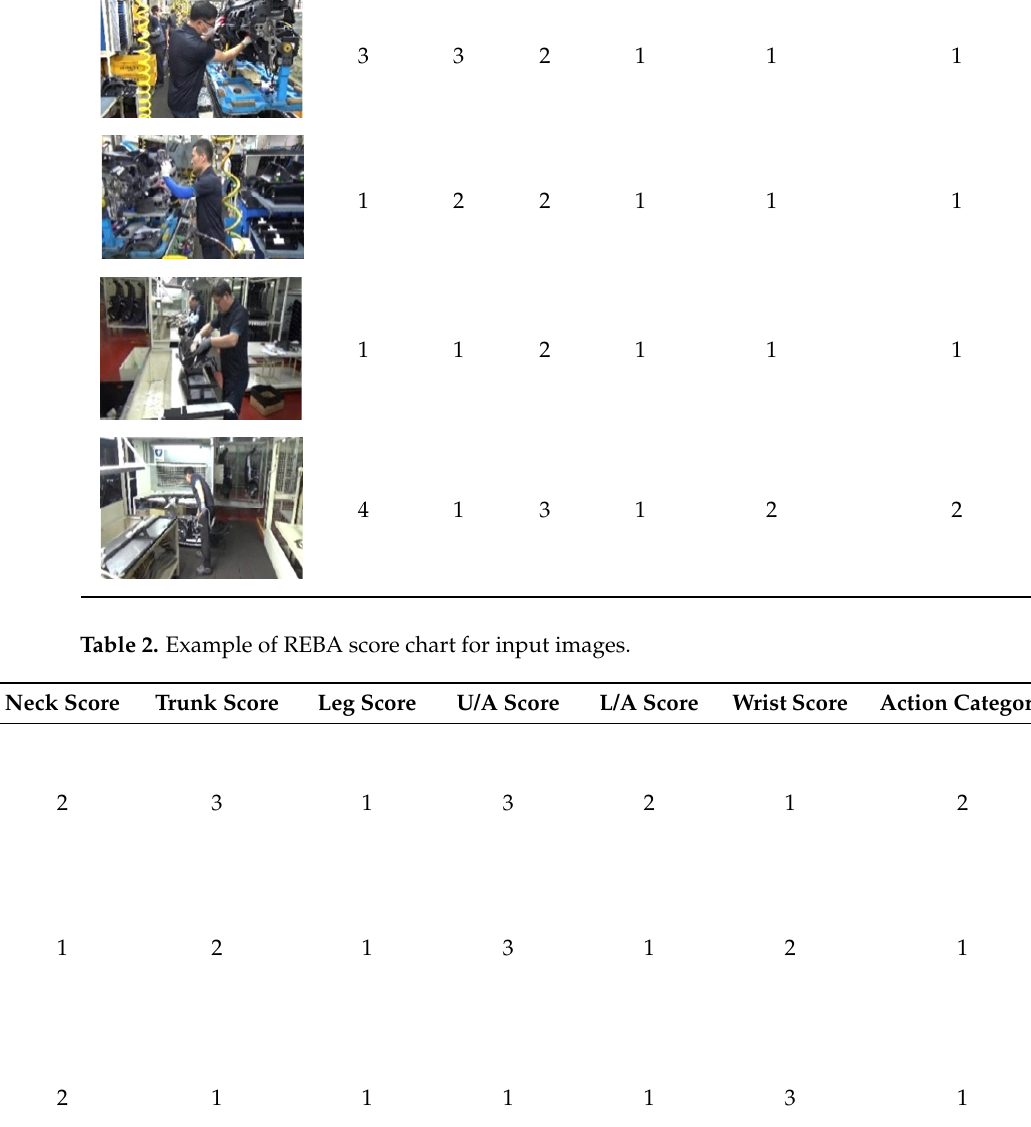
Table 2. Example of REBA score chart for input images. Table 1. Example of OWAS score chart for input images.